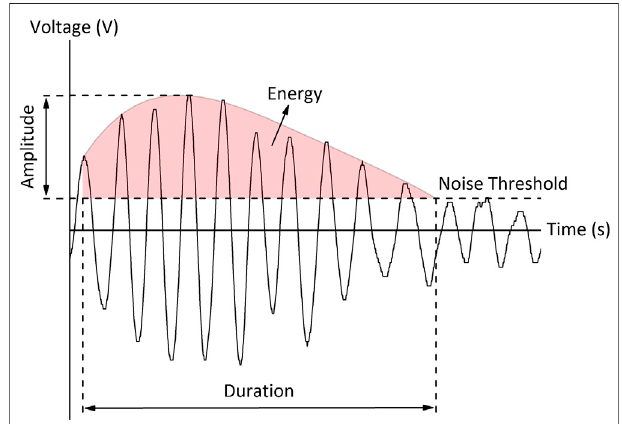
FIGURE 2 | Typical structure of an acoustic hit as voltage pro fi le as a function oftime. The acoustic hitis initiated when the signal exceeds the noise threshold and ends when the signal falls back below the threshold. The hit amplitude is the intensity of the most prominent peak within the hit, and its energy is the integrated area of the hit (adapted from Caesarendra et al.,